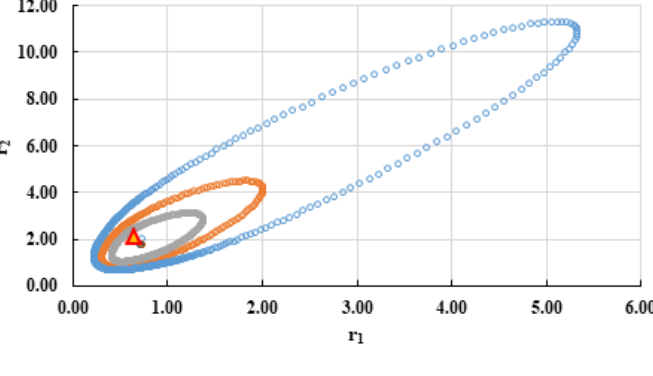
Figure 18. The JCR of analyzed methods for reactivity ratios calculation for HC3 imposed condition.